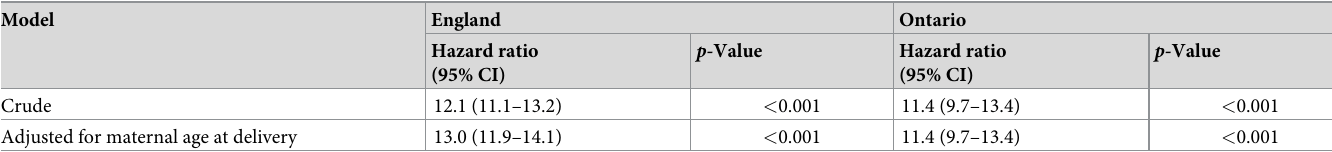
Table 4. All-cause mortality risks for mothers with infants with neonatal abstinence syndrome, crude and adjusted for maternal age at delivery, 2002 to 2016. Model